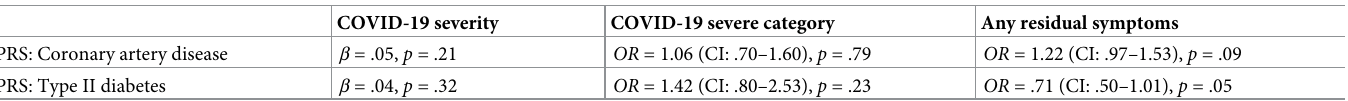
Table 3. Associations between coronary artery disease and type II diabetes PRS and COVID-19 severity and residual symptoms in participants of European ancestry.